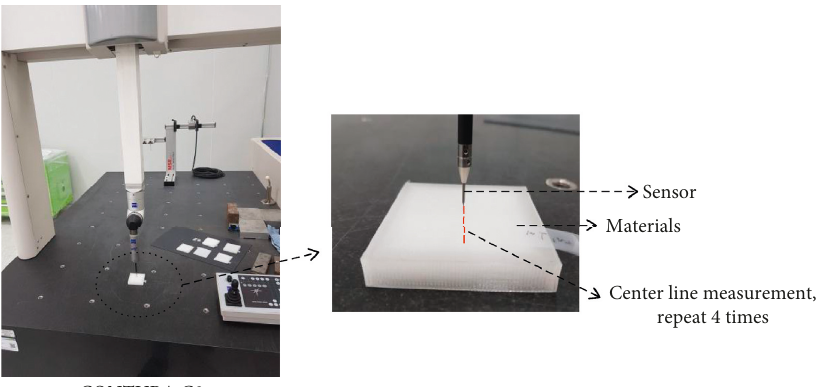
Figure 2: 3D coordinate scan method for results after impact testing.